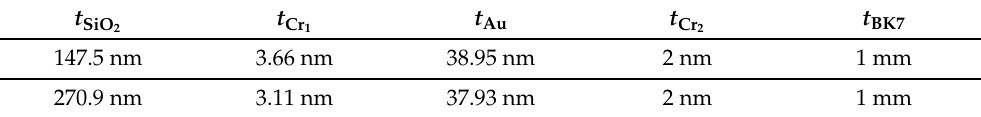
Table 3. The thickness parameters of the individual layers for both structures.